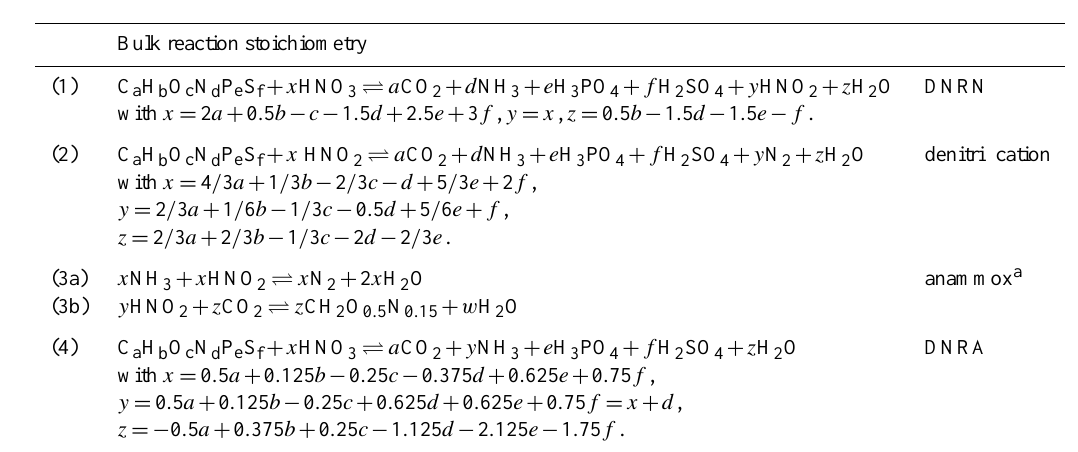
Table 1. Stoichiometric equations for (1) dissimilatory nitrate reduction to nitrite (DNRN), (2) denitrification, (3) anammox, and (4) dissim- ilatory nitrate reduction to ammonium (DNRA) for bulk organic matter with an average composition of C a H b O c N d P e S f . For simplicity and following Paulmier et al. (2009) we give the stoichiometric equations in non-ionic forms. We assume reaction of NH 3 and CO 2 with water and subsequent dissociation as well as dissociation of HNO 3 , HNO 2 , H 3 PO 4 , and H 2 SO 4 according to seawater pH. For a more detailed discussion of the derivation of Eqs. (1), (2), and (3) see Paulmier et al.